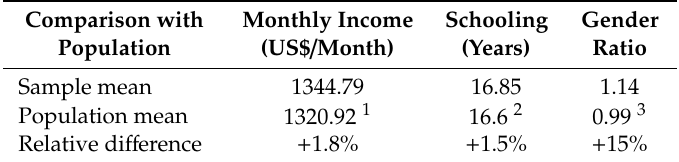
Table 2. Comparison between sample and population statistics (the gender ratio is defined as the ratio of men to women in 2016). Comparison with Monthly Income Schooling Gender Population (US$ / Month) (Years) Ratio Sample mean 1344.79 16.85 1.14 Population mean 1320.92 1 16.6 2 0.99 3 Relative di ff erence + 1.8% + 1.5% + 15%